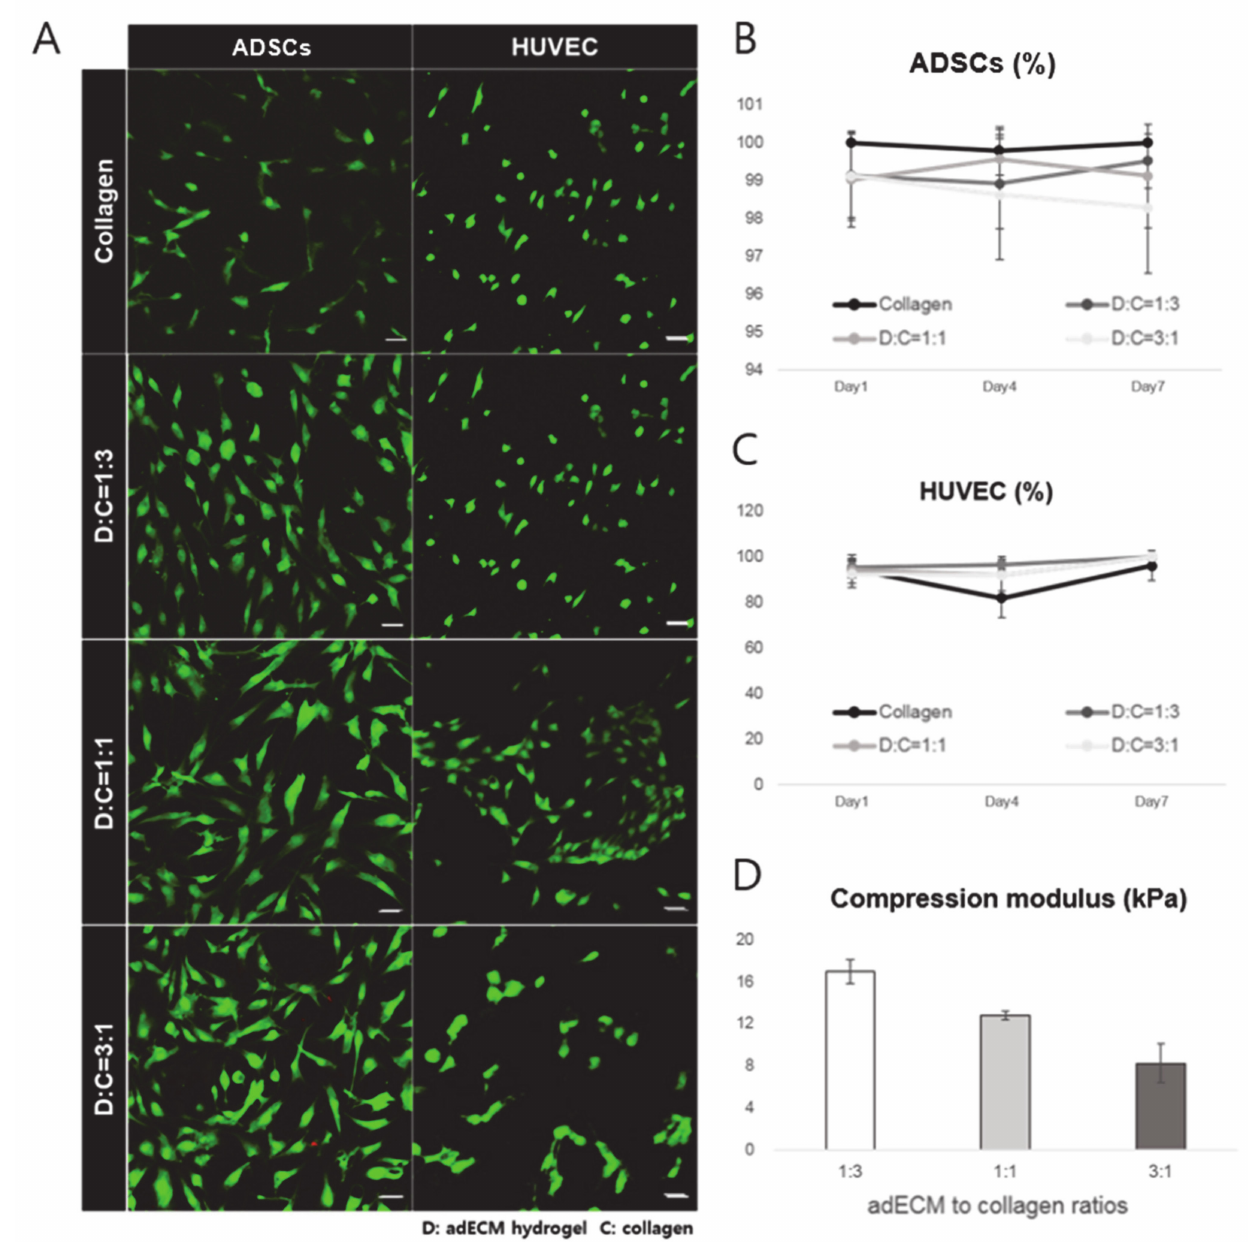
Figure 4. ( A ) LIVE/DEAD assay. Cell viability test was performed to optimize the hydrogel composition. Adipose- derived stem cells (ADSCs) and human umbilical vein endothelial cells (HUVECs) were seeded onto each of the hydrogels. The confocal images above were obtained after a 7-day incubation of cells. Green and red fluorescence represents live and dead cells, respectively. Scale bar = 50 µ M. ( B ) Cell viability results of ADSCs. ( C ) Cell viability results of HUVEC. ( D ) Compression modulus of each hydrogel. All samples were evaluated in triplicate, and the error bar indicates the